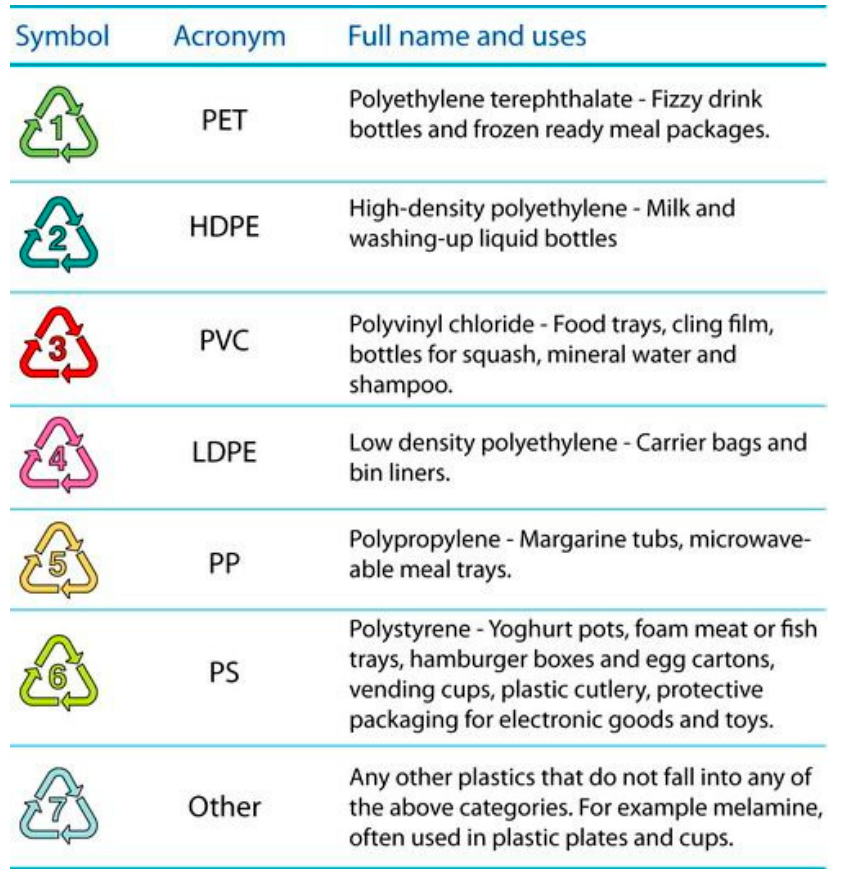
Figure 2. Plastics identification code. Adapted from [6], with permission from © 2016 Elsevier.